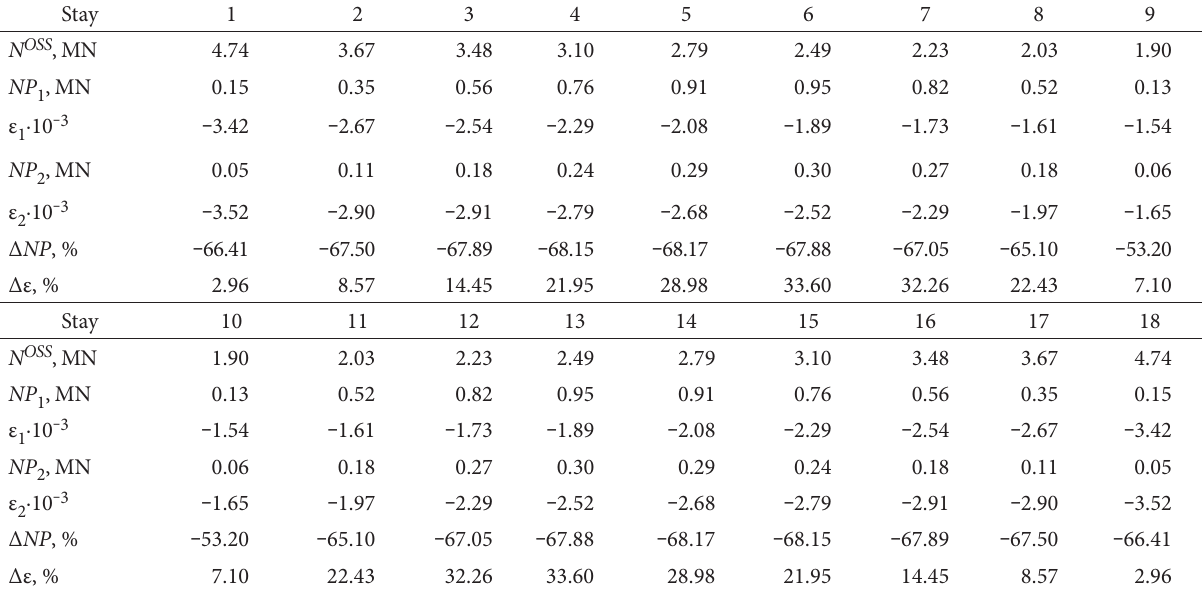
table 6. Stay forces in the OSS , passive forces in the stays and suitable strains without (1) and including (2) the effect of the staggered erection of the superstructure for the bridge in WuXi and percentage differences